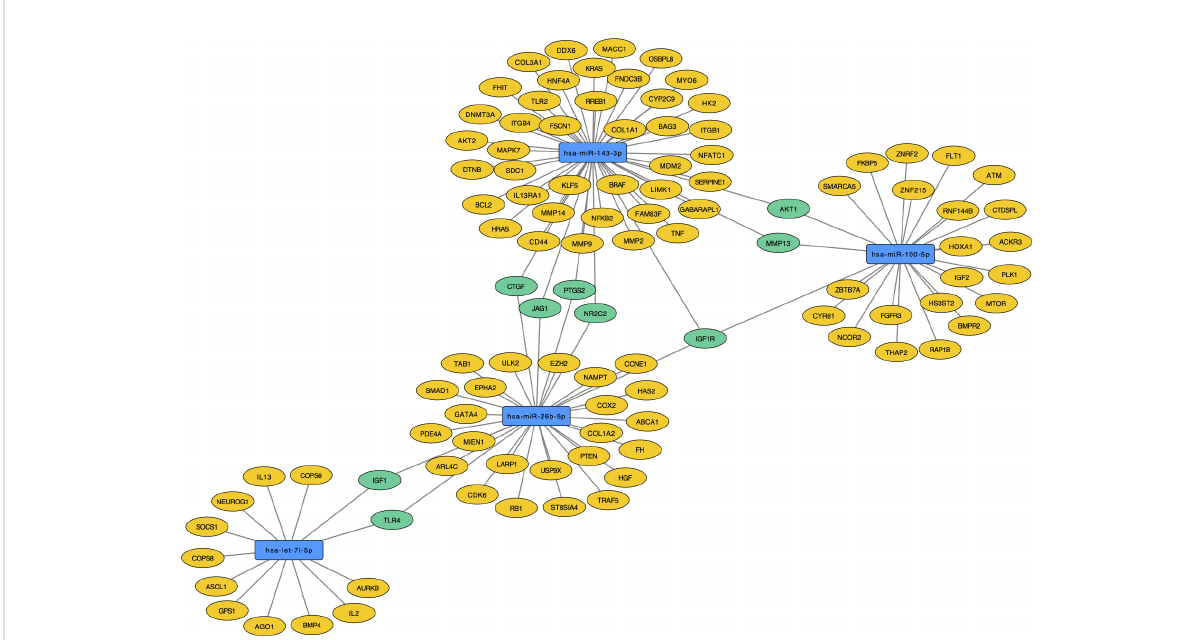
FIGURE 7 Target genes of validated miRNAs (blue) with strong evidence in T1DM. Those regulated by at least two of the miRNAs are pictured in green and those solely regulated by one of the validated miRNAs are picture in yellow.